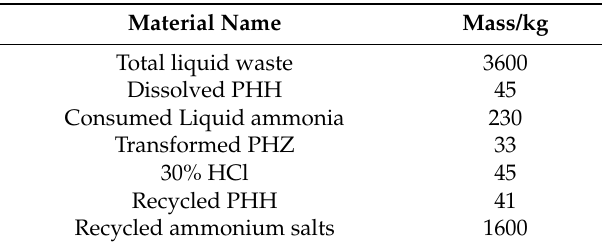
Table 2. Results of the treatment of PHH production